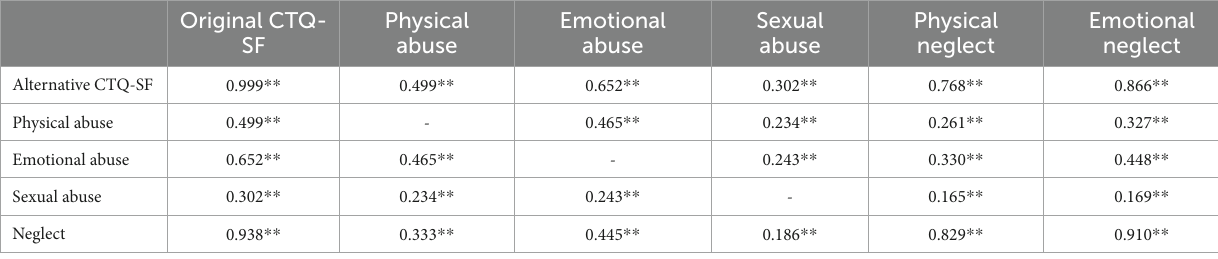
TABLE 4 Correlations between the original and alternative CTQ-SF.